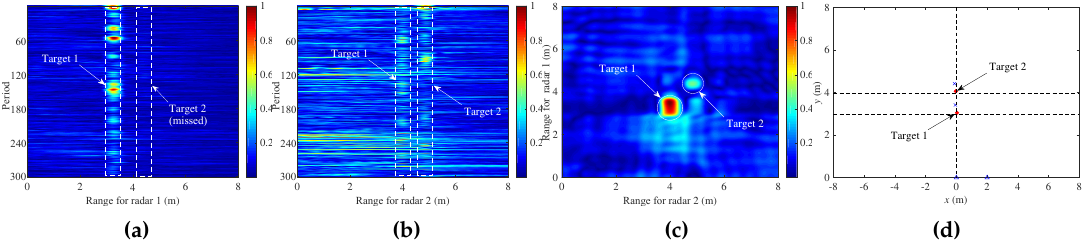
Figure 13. Results of Experiment 2.2 with 2 m interval between two radars: ( a ) range profile plane for Radar 1; ( b ) range profile plane for Radar 2; ( c ) cross-correlation image; and ( d ) localization result.